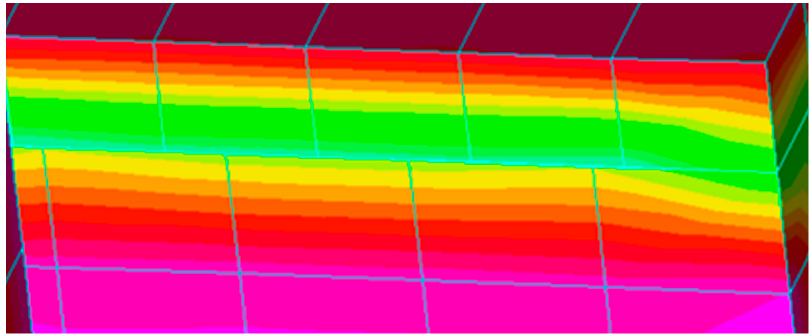
Figure 20. Distribution of temperature between the interior and exterior surface.